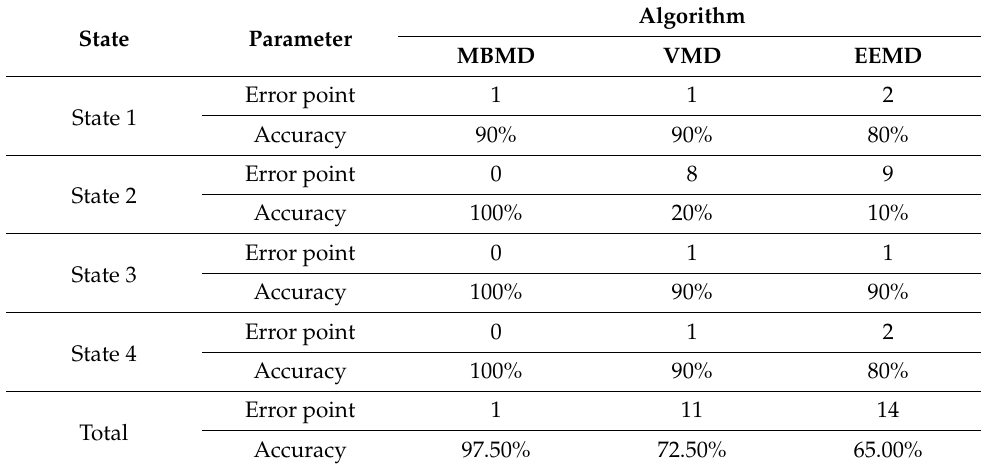
Table 7. BP classification parameters of the three